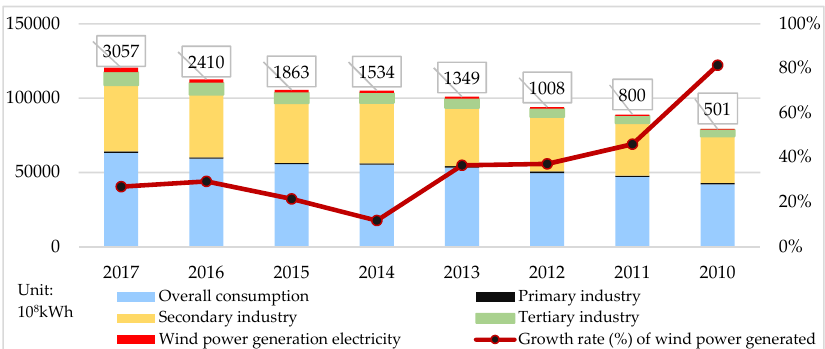
Figure 9. Energy consumption structure and wind power generation electricity of China during 2010–2017. (Data in the label refers to magnitude of wind power generation electricity and the data is collected and integrated with references [8,64,65] and NEA).